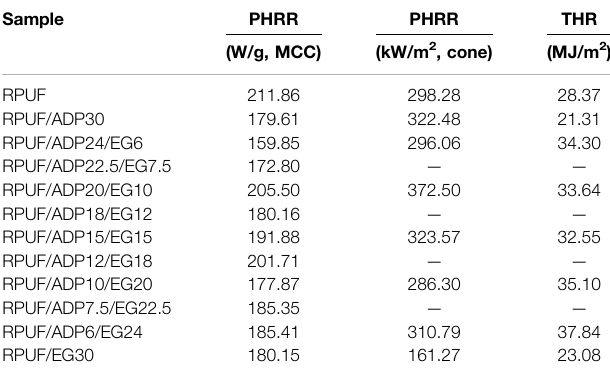
TABLE 5 | PHRR and THR from MCC and